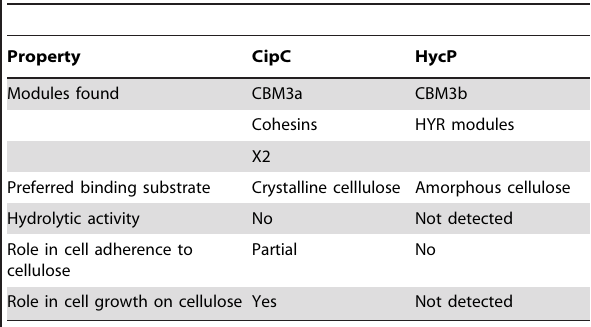
Table 2. Summary of the compared properties of CipC and